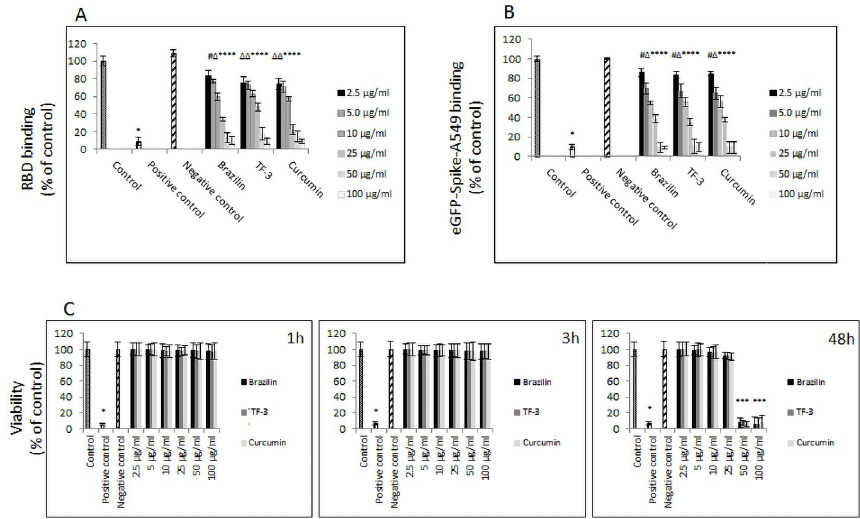
Fig 1. Binding of RBD-spike protein of SARS-CoV-2 to human ACE2 receptor. (A) Dose-dependent binding of RBD-SARS-CoV-2 to immobilized hACE2 receptor. Control– 0.025% DMSO, positive and negative controls were provided by the manufacturer; data are presented as % of control ± SD. (B) Dose-dependent binding of A546 cells expressing SARS-CoV-2 eGFP-spike protein, in the presence of indicated polyphenols at different concentrations, to soluble hACE2 receptor. Control– 0.25% DMSO; positive and negative controls were provided by the manufacturer; data are presented as % of control ± SD. (C) Viability of A549 cells, positive control—100% dead cells, negative